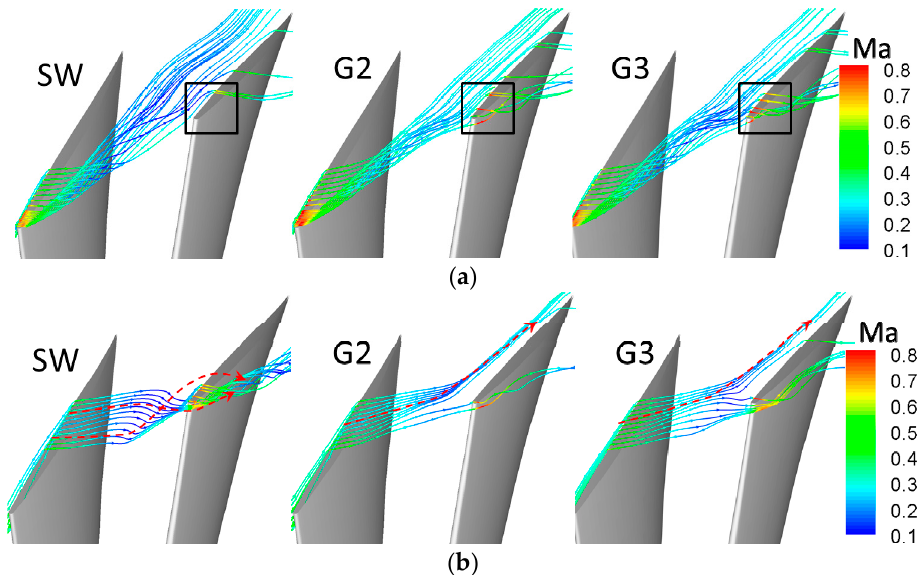
Figure 15. Time-averaged 3D flow streamlines released from mid-gap within different chord range colored with relative Mach number: ( a ) blade leading edge—30% axial chord; and ( b ) 30–60% axial